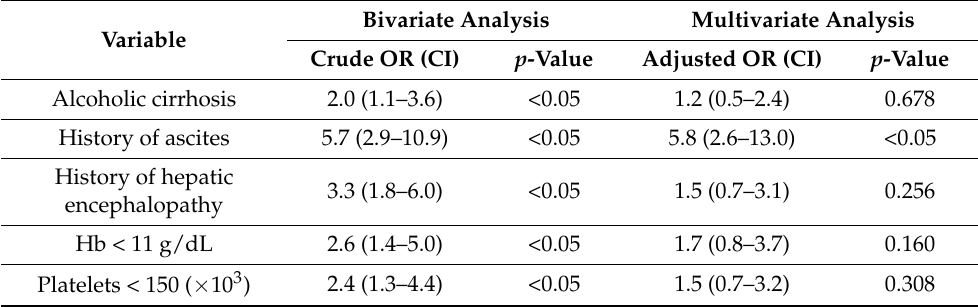
Table 3. Odds of development of HRS in a bivariate and multivariate